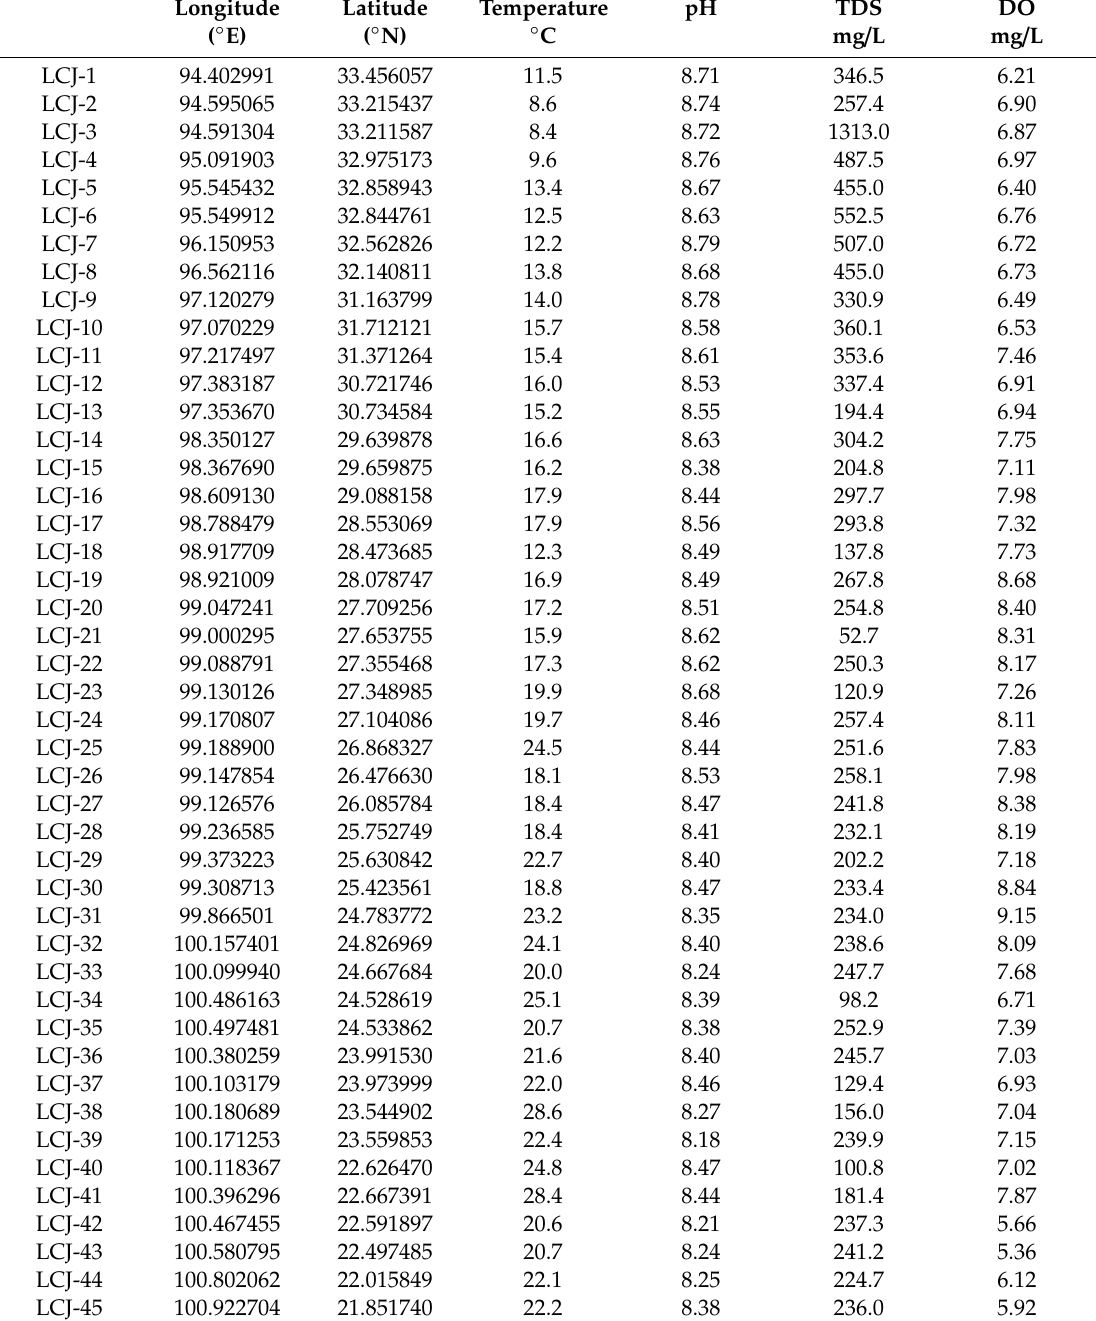
Table 1. The sampling coordinates and water parameters obtained from field